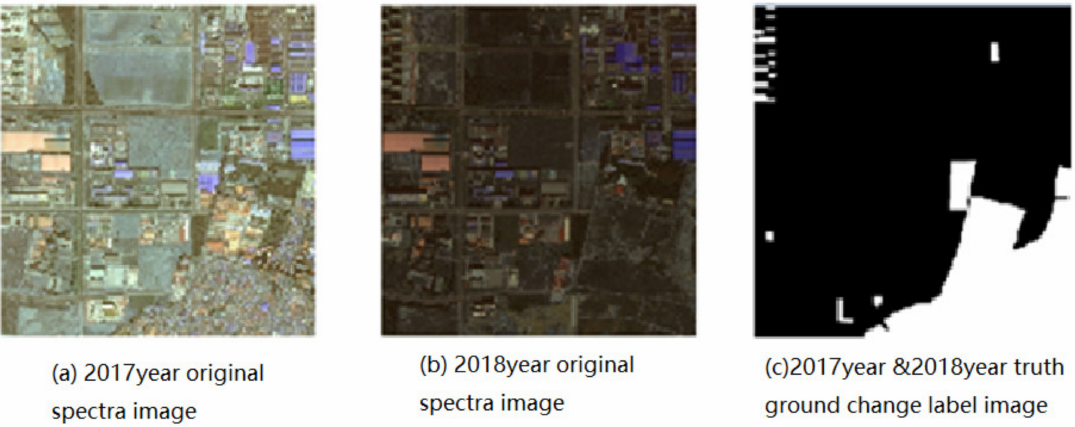
Figure 18. Public dataset.